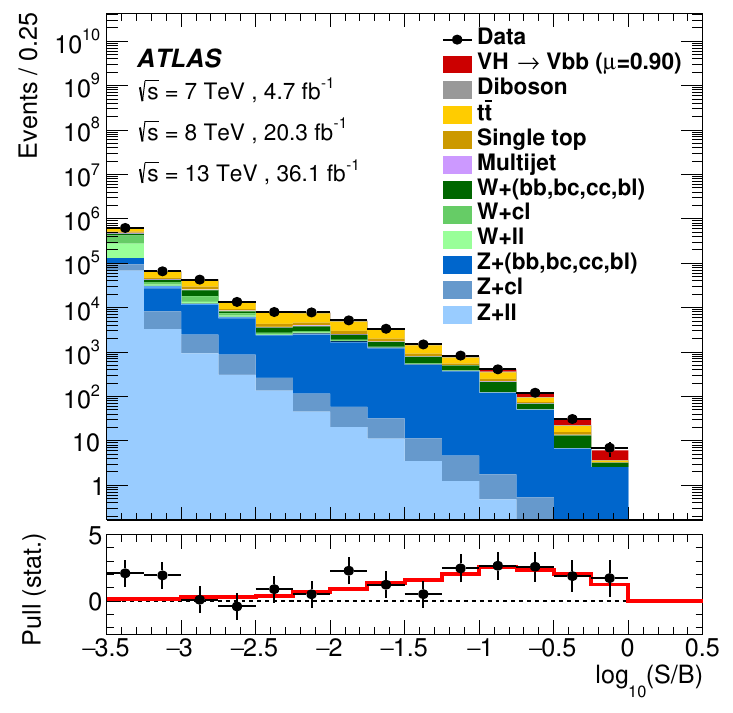
Figure 13 . Event yields as a function of log( S=B ) for data, background and Higgs boson signal with m H = 125 GeV, for the 7 TeV, 8 TeV and 13 TeV datasets combined. Final-discriminant bins in all regions are combined into bins of log( S=B ), with the (cid:12)tted signal being S and the (cid:12)tted background B , for the 7 TeV, 8 TeV and 13 TeV datasets combined. The Higgs boson signal contribution is shown after rescaling the SM cross-section according to the value of signal strength extracted from data ( (cid:22) = 0 : 90). The pull (residual divided by its uncertainty) of the data with respect to the background- only prediction is also shown with statistical uncertainties only. The full line indicates the pull of the prediction for signal ( (cid:22) = 0 : 90) and background with respect to the background-only prediction.